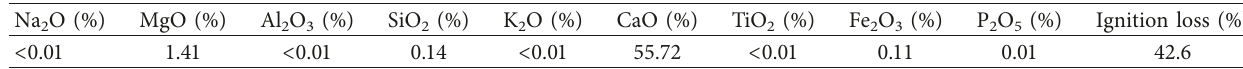
Figure 3: Marble powder used for MSWC and MSCC production. Table 7: Chemical properties of marble.